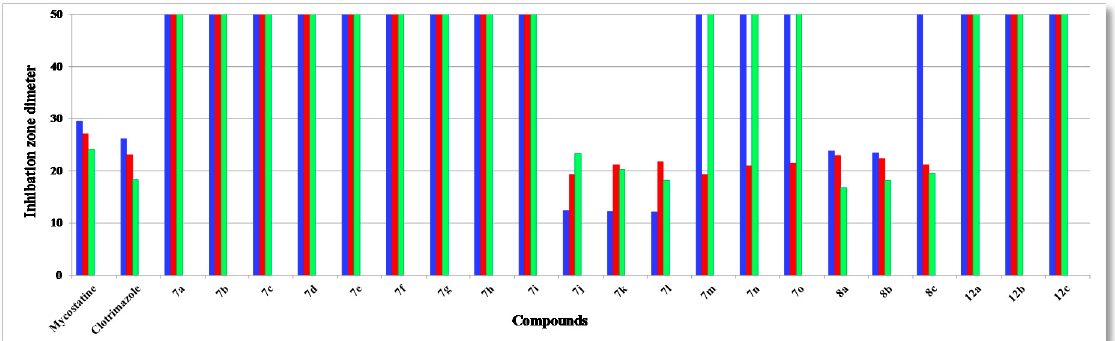
Figure 3. Antifungal activity of tested compounds compared to mycostatine and clotrimazole: A. fumigatus (blue); C. albicans (red) and S. cerevisiae (green).